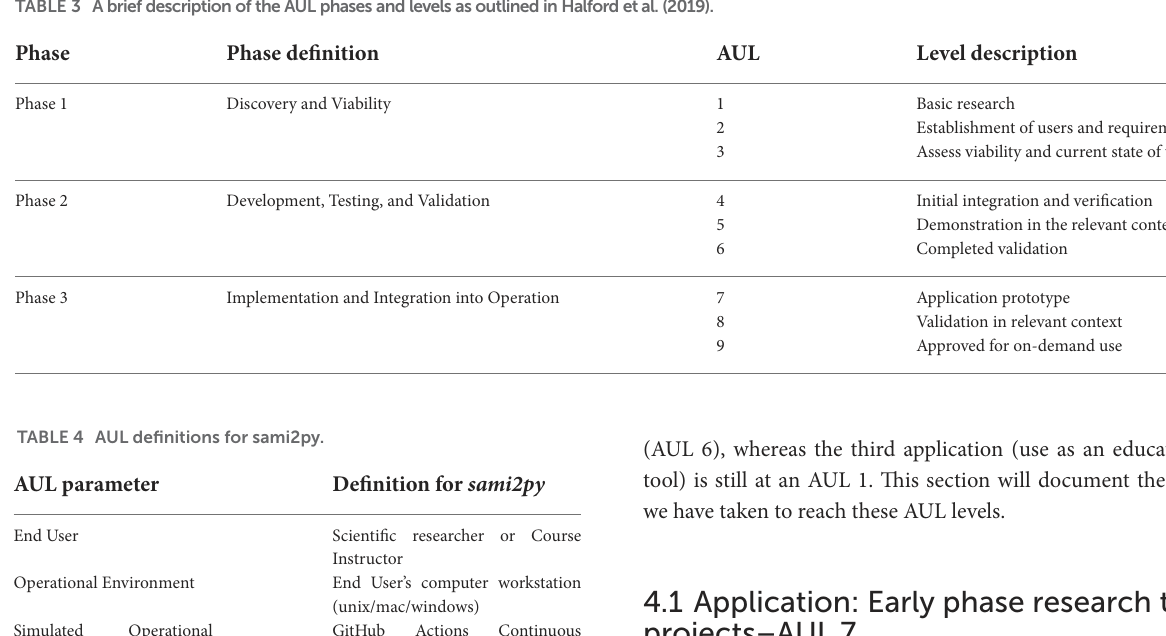
TABLE 3 AbriefdescriptionoftheAULphasesandlevelsasoutlinedinHalfordet al.(2019).